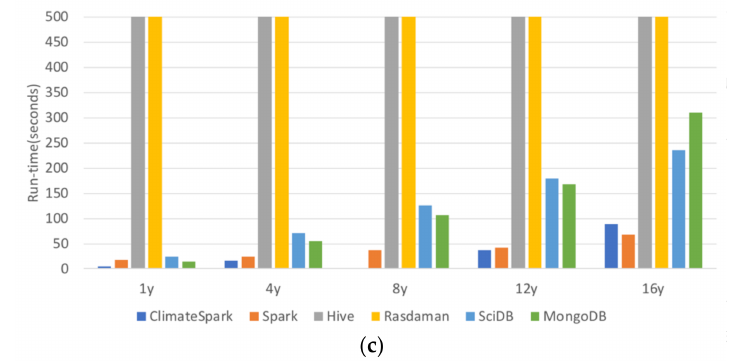
Figure 8. The spatiotemporal query for the 4D variable at: ( a ) the point (Boulder) time series query by varying the time range; ( b ) the area average for the Colorado State by varying the time range; and ( c ) the global average by varying the time range.